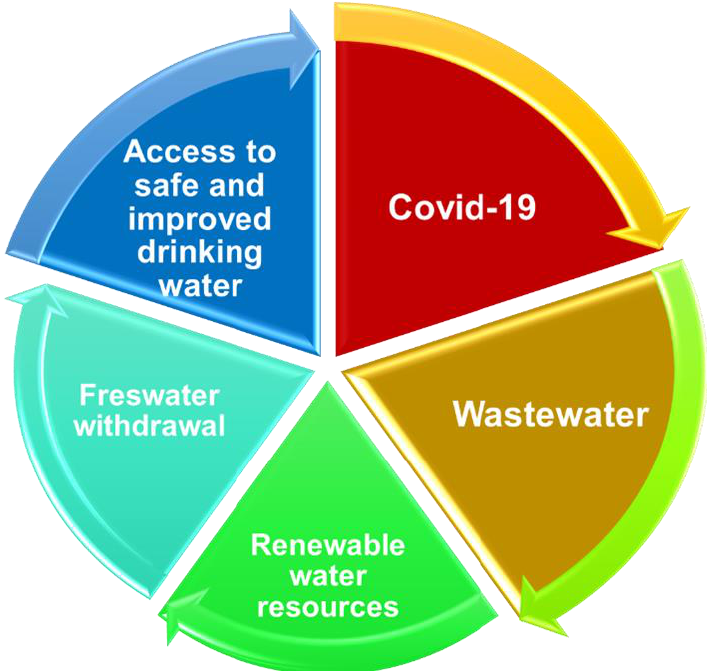
Figure 2. The interdependence of COVID-19 and water-related variables .